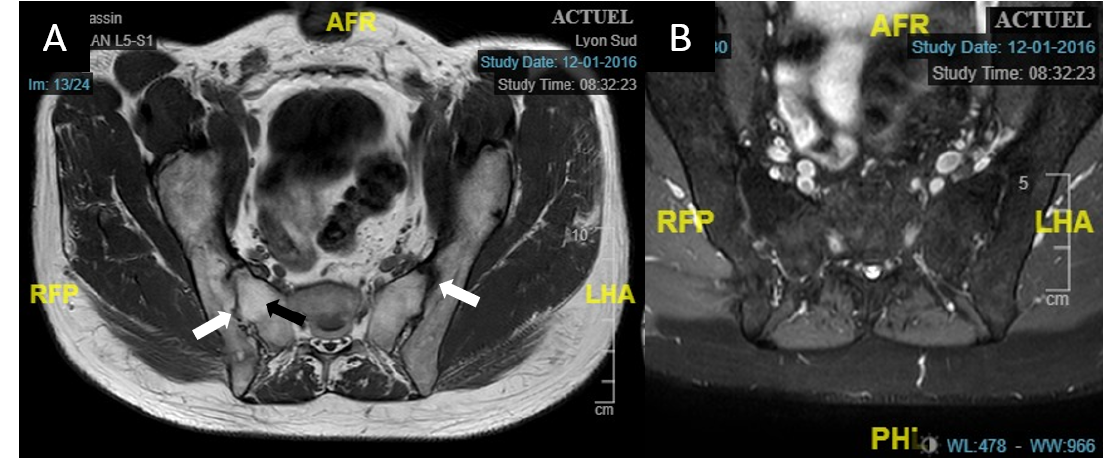
Figure 2. Axial sacroiliac MRI of case 1. ( A ): T1-weighted sacroiliac axial MRI of case 1 showing major joint reshaping in the form of hypo dense areas bordering the joint (white arrows) as well as ankylosis of the right sacroiliac joint with a T1 hypersignal of the subchondral bone. ( B ): T2 SPAIR axial sequence without hypersignal of the sacroiliac joints, indicating the absence of active involvement. Abbreviations: A = anterior, P= posterior, R = right, L = left, H = head, F = foot; MRI: magnetic resonance imaging; T2 SPAIR: T2 Spectral Attenuated Inversion